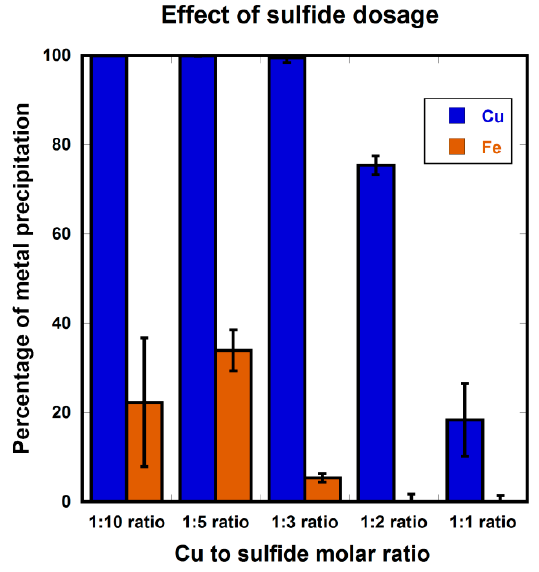
Figure 7. E ff ect of sulfide dosage on copper sulfide Figure 7. Effect of sulfide dosage on copper sulfide precipitation.